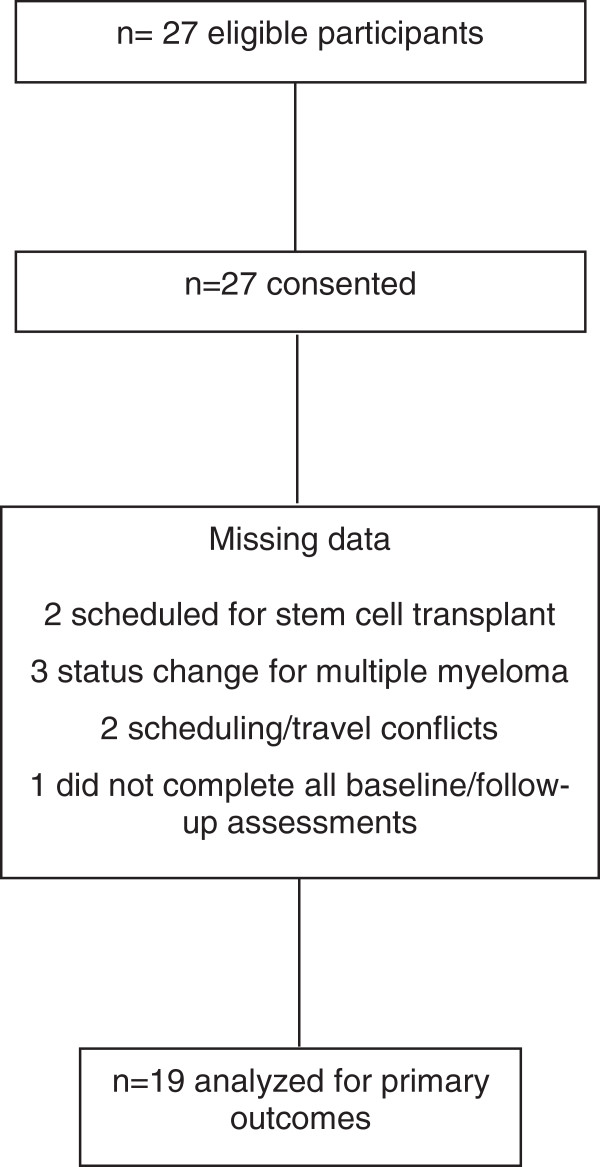
Study flow diagram.